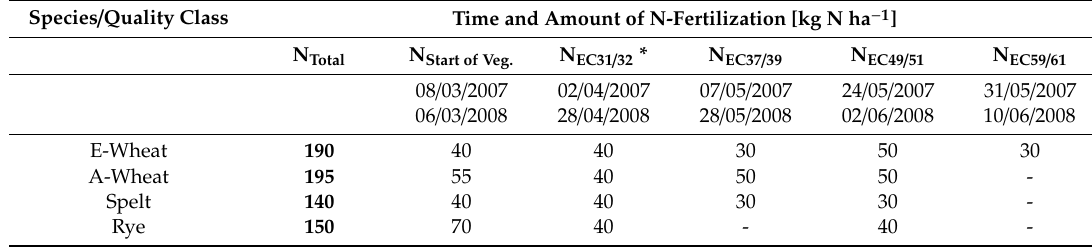
Table 4. Time and amount of the N-fertilization for the conventionally produced species. The two dates refer to the application date for the single growing season. Species / Quality